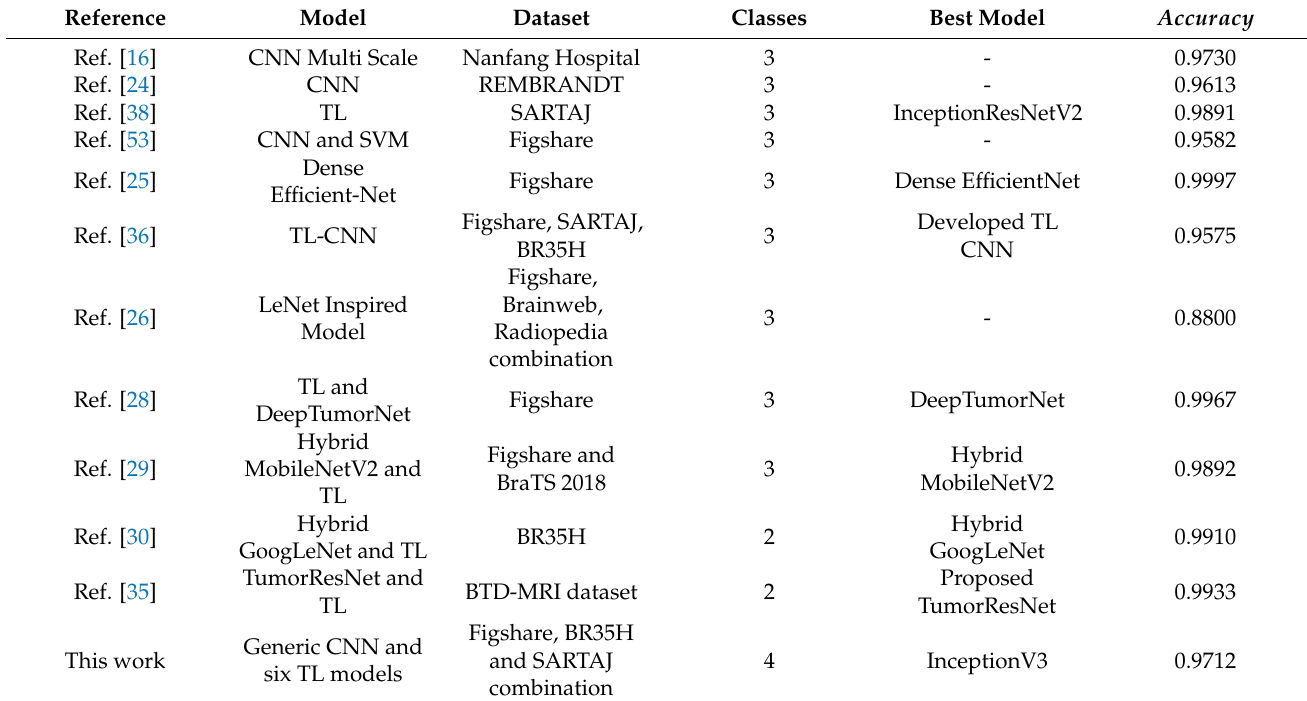
Table 8. Comparison with related